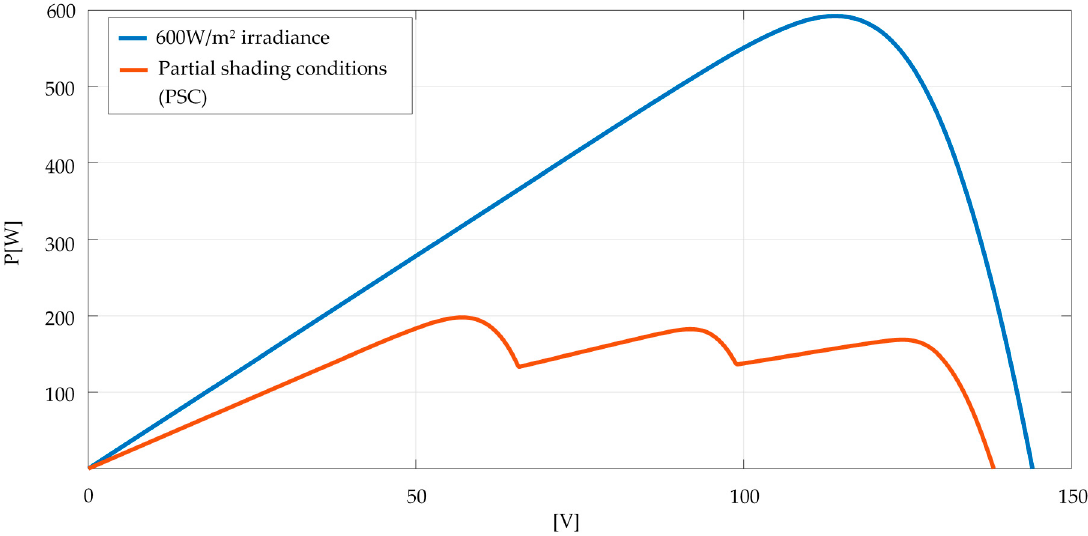
Figure 30. Power-voltage (P-V) curve with uniform 600 W/m 2 irradiance (blue) and P-V curve due to PSC phenomena (red) in BiCiSOLAR charging station.